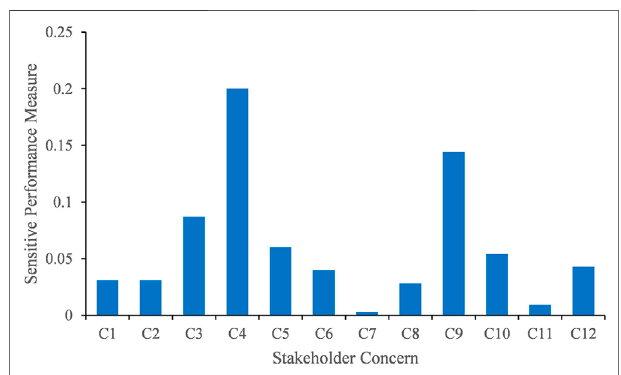
FIGURE 7 | Ranking of stakeholder concerns according to the case study sensitivity analysis.